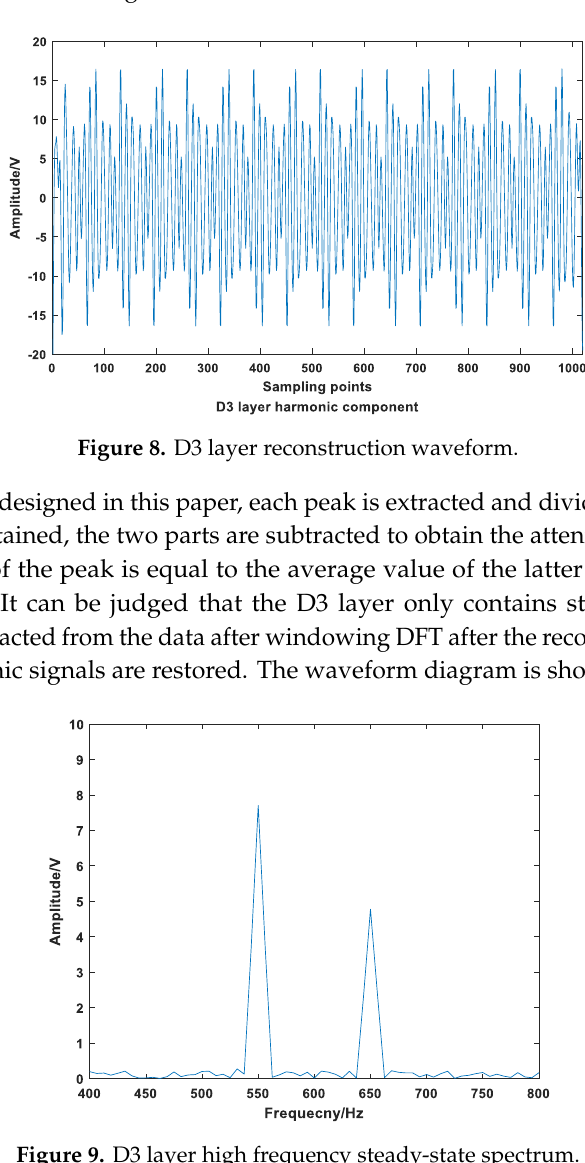
Figure 9. D3 layer high frequency steady-state spectrum.